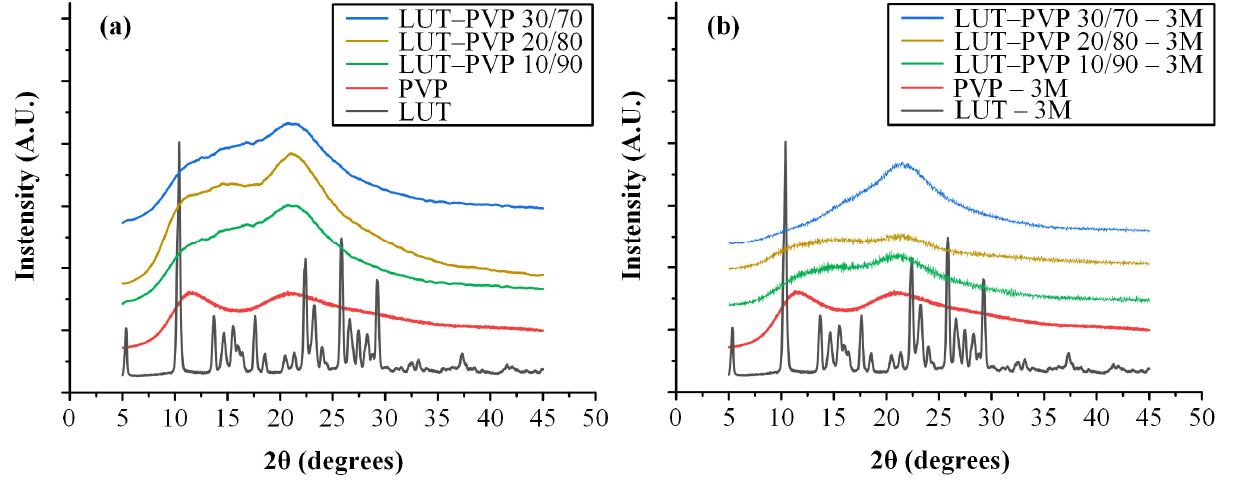
Figure 5. pXRD diffractograms for the raw materials (LUT and PVP) and the LUT–PVP ASDs ( a ) immediately after preparation and ( b ) after storage for 3 months (3M).